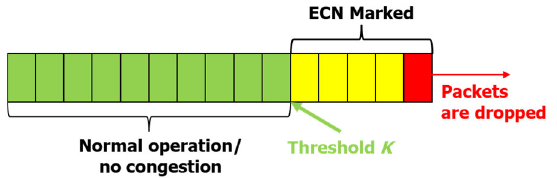
Figure 4. A conceptual sketch of the packet queue of a router detailing the ECN mechanism.